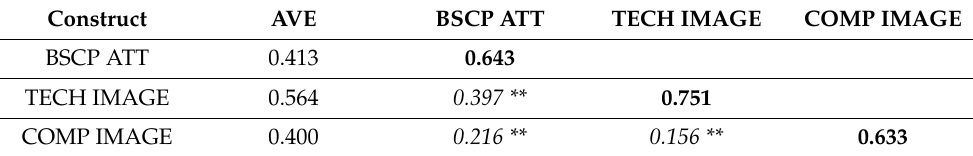
Table 8. Convergent, discriminant, and divergent validity for the dependent constructs. Construct AVE BSCP ATT TECH IMAGE COMP IMAGE BSCP ATT 0.413 0.643 TECH IMAGE 0.564 0.397 ** 0.751 COMP IMAGE 0.400 0.216 ** 0.156 **